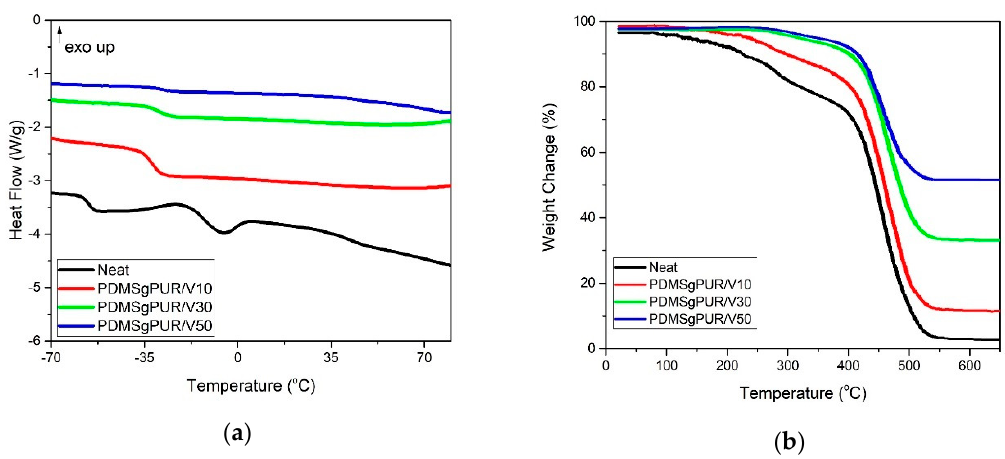
Figure 6. ( a ) Differential scanning calorimetric (DSC) curves of PDMS -g- PUR ( neat ) and PDMS -g- PUR/V 2 O 5 composites and ( b ) thermogravimetric analysis of PDMS -g- PUR ( neat ) and PDMS -g- PUR/V 2 O 5 composites.